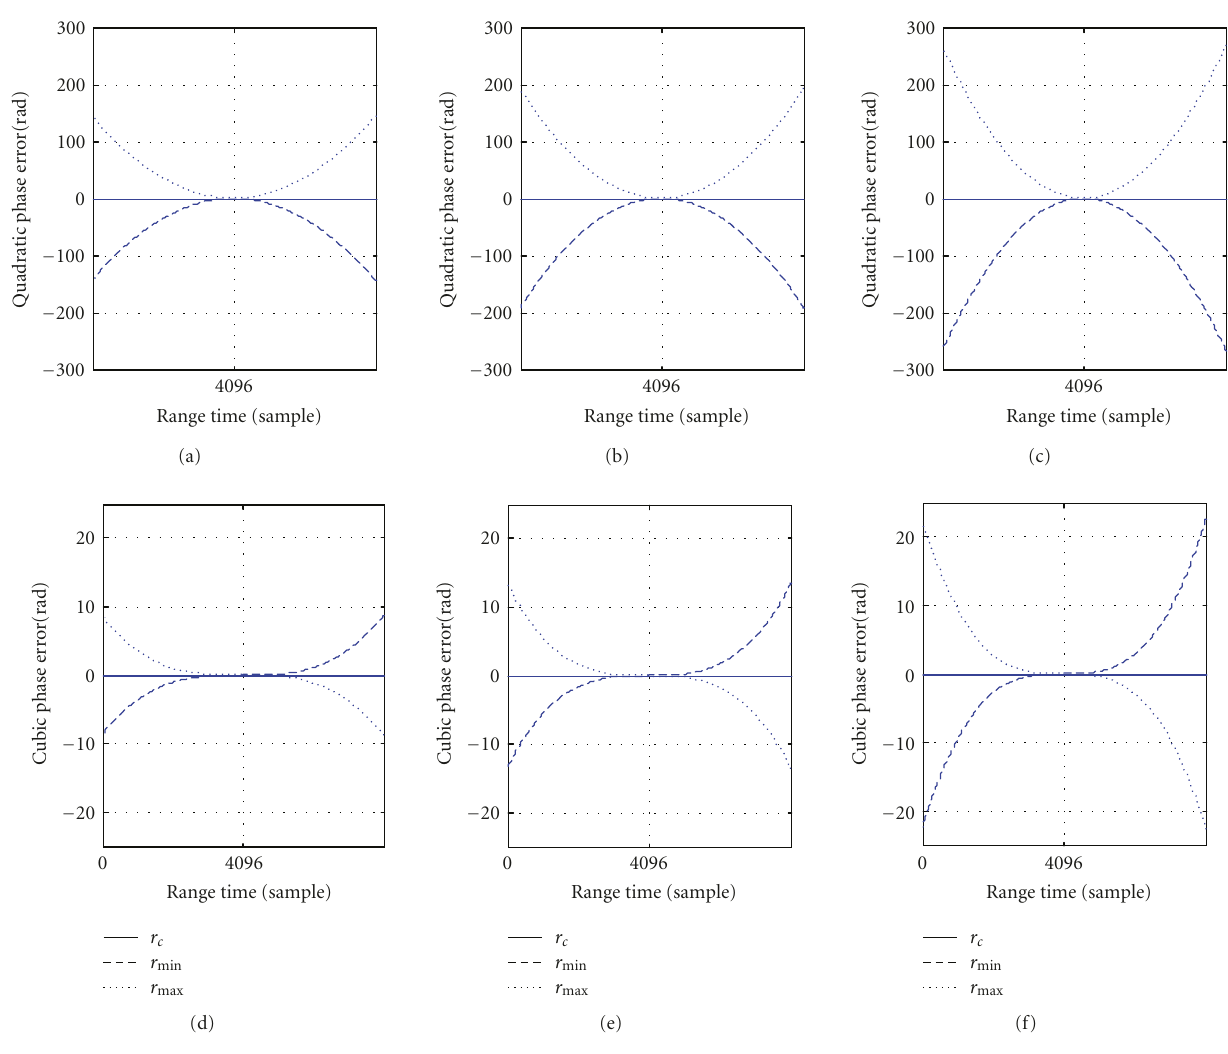
Figure 2: (a), (b), and (c) present the quadratic phase error ϕ 2 − ϕ 2 ( r c ) in the case of β ( − PRF/2) = 0.5394, β (0) = 0.5, and β (PRF/2) = 0.4559, respectively. (d), (e), and (f) present the cubic phase error ϕ 3 − ϕ 3 ( r c ) at three di ff erent β values 0.5394, 0.5, and